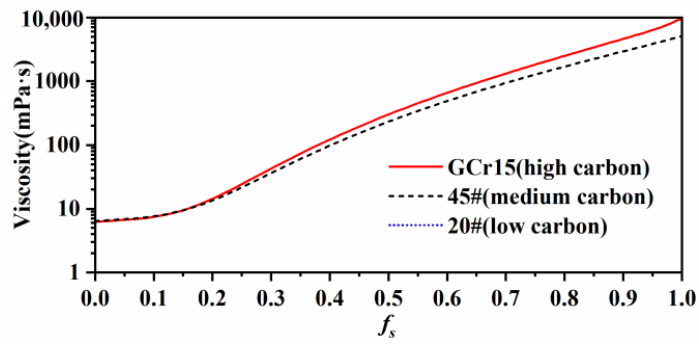
Figure 7. Viscosity variation with solid fraction.